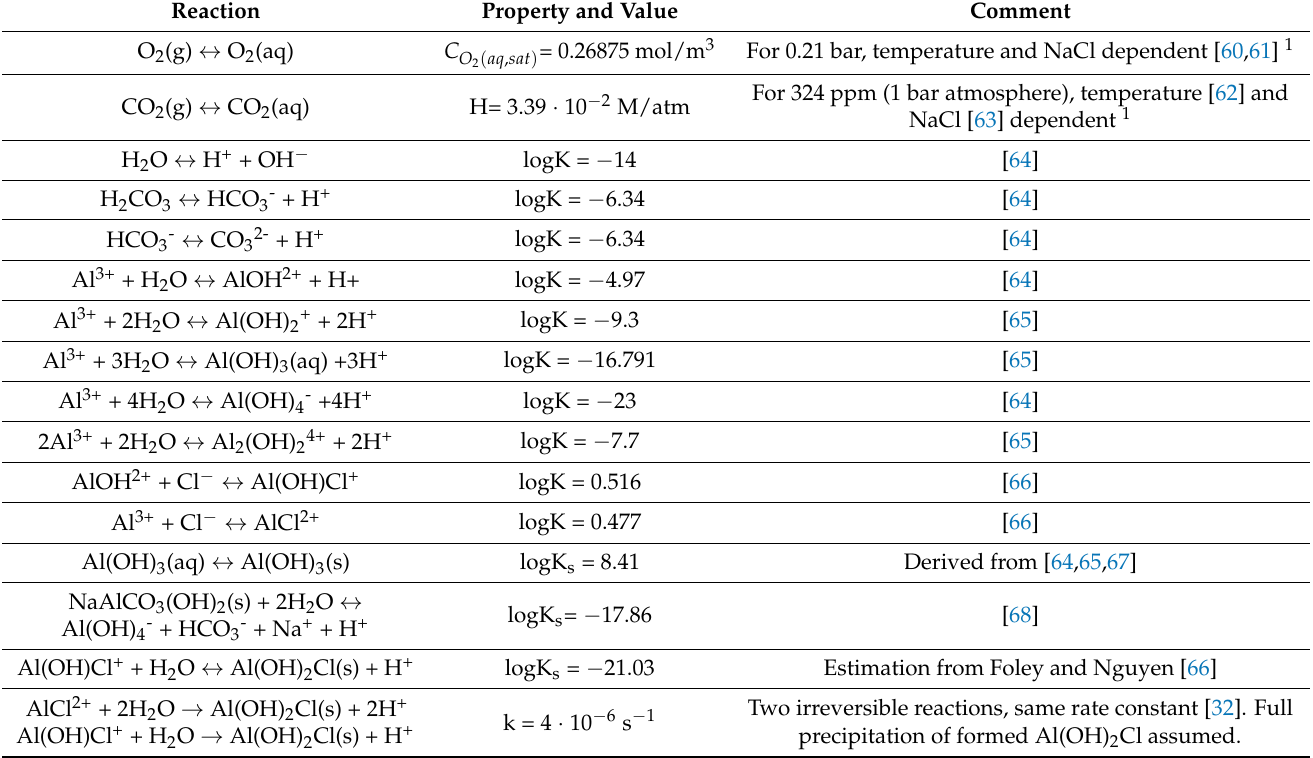
Table 1. Homogeneous and heterogeneous reaction system at 25 ◦ C.